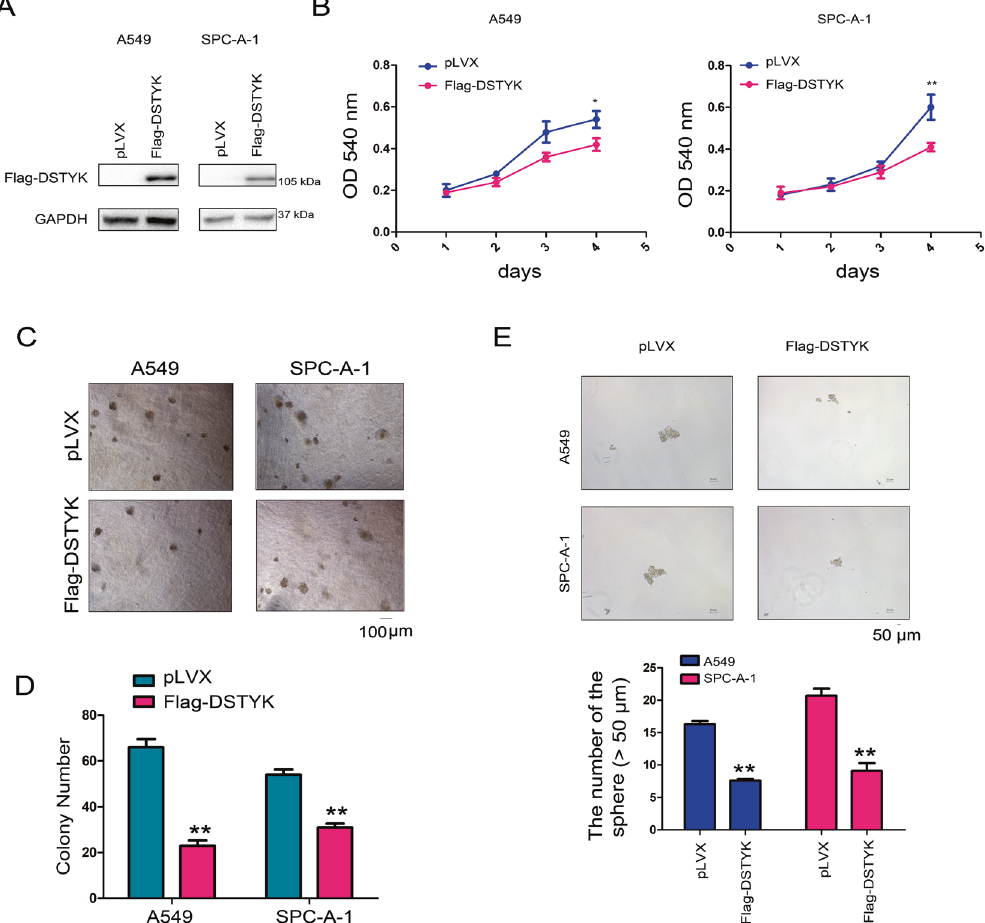
Fig. 2 DSTYK inhibited the growth of A549 and SPC-A-1 cells. A Western blot was performed to examine the overexpression of DSTYK. A549 and SPC-A-1 cells were infected with lentivirus expressing Flag-tagged DSTYK and selected with puromycin. Then, western blotting